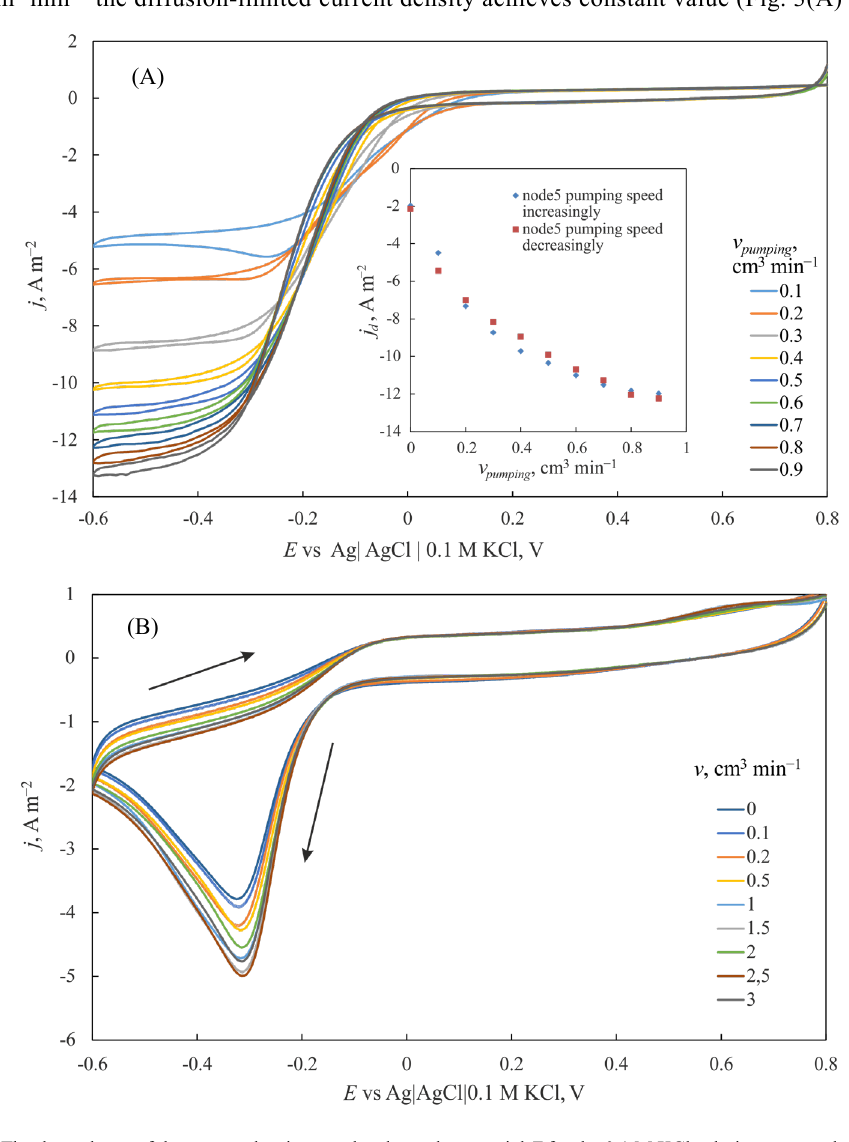
Fig. 3. The dependence of the current density j on the electrode potential E for the 0.1 M KCl solution saturated with oxygen ( p tot = 101 kPa) for: (A) the flow through cell only with channel (1st cycle), and (B) oxygen sensor array (2nd cycle) at different pumping speeds. The potential sweep rate was 20 mV s −1 . Inset in Fig 3(A): the dependence of the limiting current density j d , on the pumping speed of the solution, v pumping (node